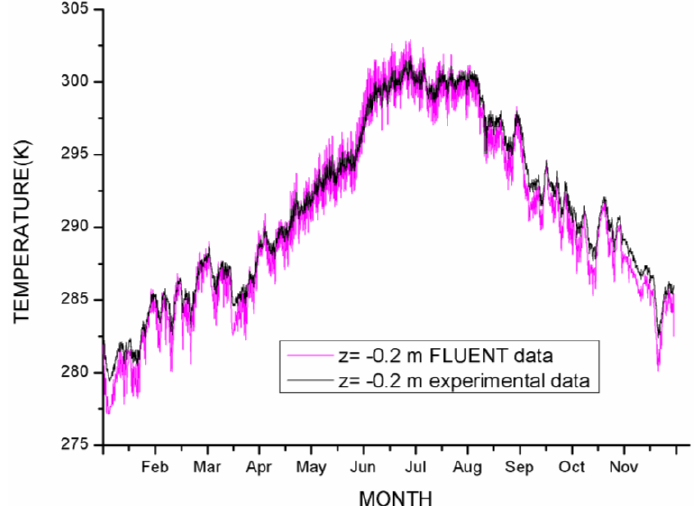
Figure 6. Comparison between the experimental data and the results from the CFD simulations